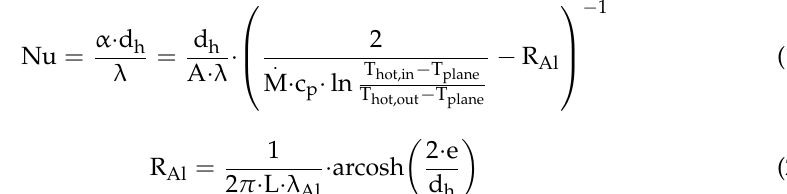
Resistance thermometer Pt100 with data logger: NI9213 (National Instruments) ∆ T ≤ ± 0.023 K Thermocouple Typ K with data logger: NI9203 (National Instruments) and external reference temperature